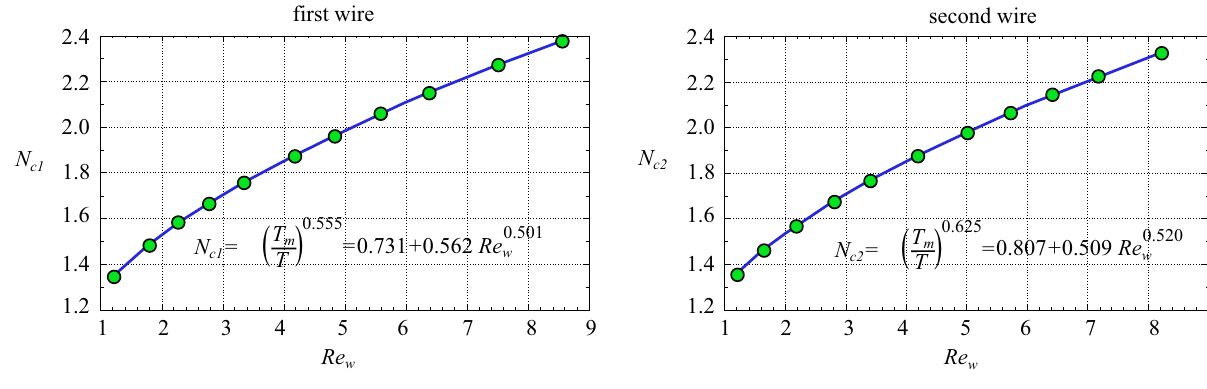
Fig. 2 Sample hot-wire blowdown calibration curve for first w 1 and second w 2 wire. Accordingly, the w 1 and w 2 are streamwise and span com- ponents. The blue line and green dots are the calibration curve and the experimental data,